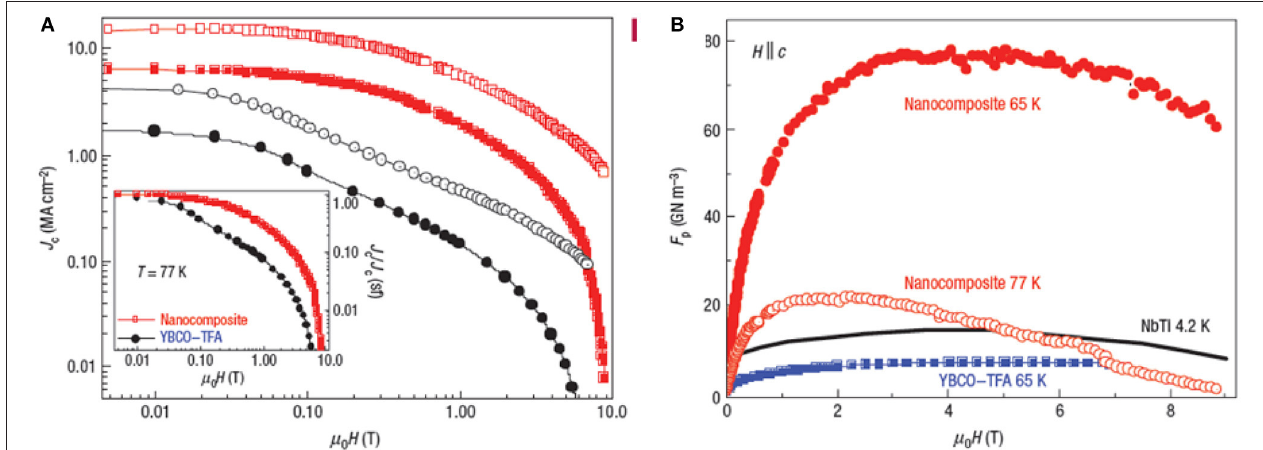
FIGURE 9 | (A) Variation of J c with applied magnetic field for YBCO:BZO(10%) nanocomposite film (red symbols) and a pristine YBCO sample (black symbols) grown by CSD technique. The solid and hollow symbols correspond to the data measured at 77 and 65K, respectively. In the inset, variation of the normalized J c with applied magnetic field at 77K for pristine and nanocomposite films is shown. (B) Variation of F p with applied magnetic field for the nanocomposite film at 65 and 77K in comparison with that of pristine YBCO at 65K and NbTi wires at 4.2K. Reprinted from Gutierrez et al. [ 86], with the permission from Springer Nature ©